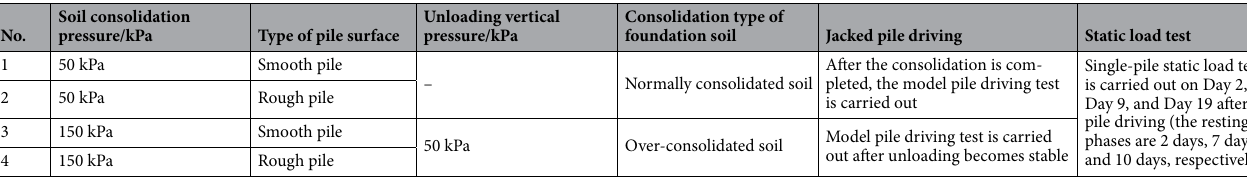
Table 2. Test scheme.